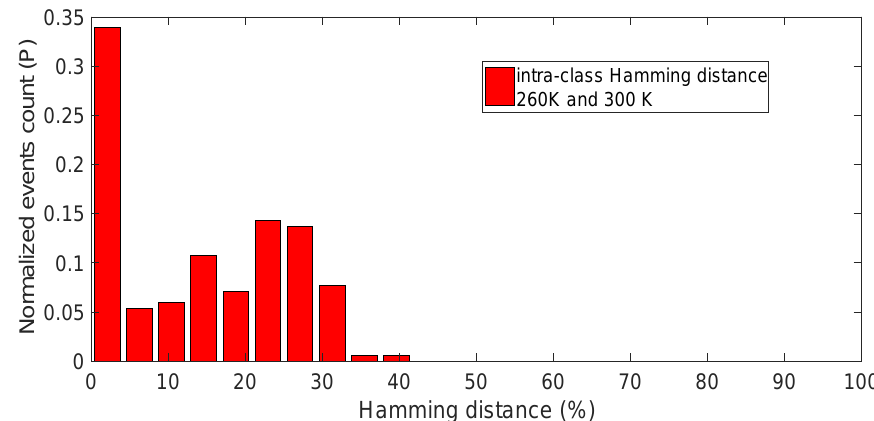
Figure 15. Deterministic density function for Hamming distances at two different